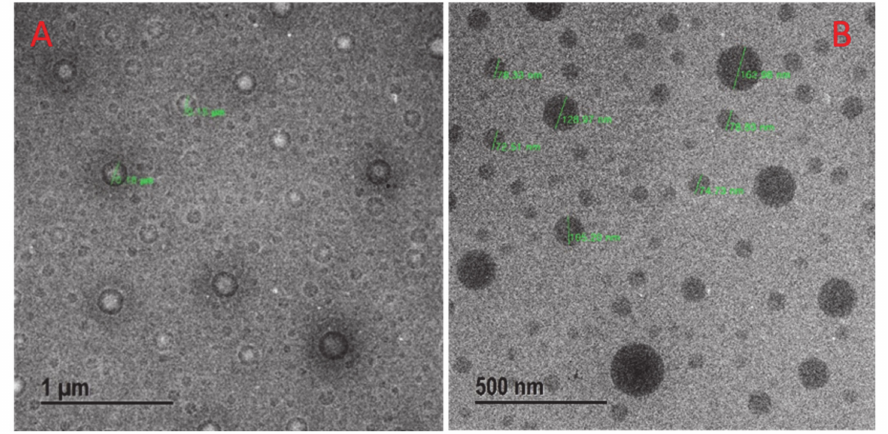
Figure 2. FE-TEM images indicated the spherical shape of Cordyceps nanoemulsion at ( A ) 1 µ m and ( B ) 500 nm.